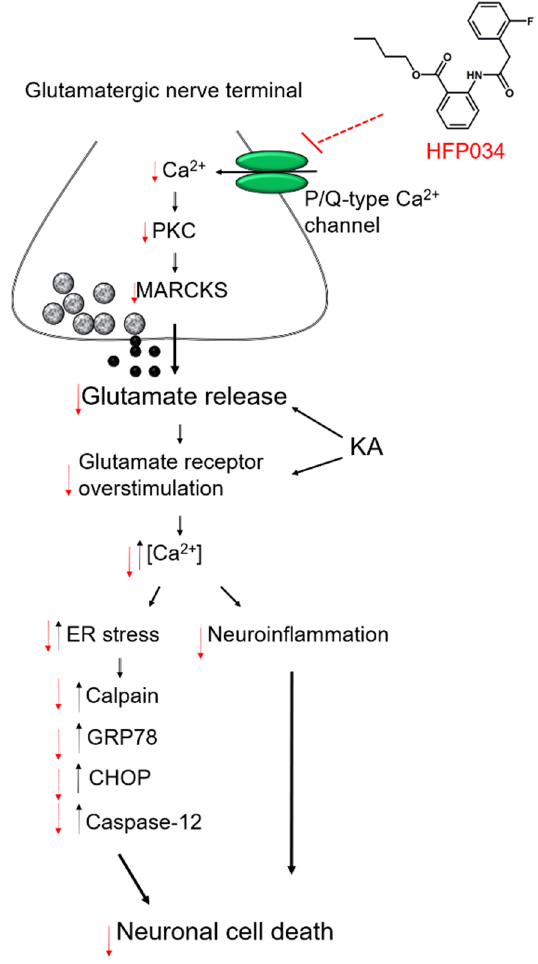
Figure 8. A proposed mechanism underlying the inhibition of glutamate release and glutamate excitotoxicity by HFP034 in rats. HFP034 depresses glutamate release via suppressing presynaptic P/Q-type Ca 2+ channels and PKC/MARCKS pathway, as well as protecting KA-induced neuronal death via ER stress and neuroinflammation inhibition. Black arrows indicate positive regulation, and red arrows indicate negative regulation.